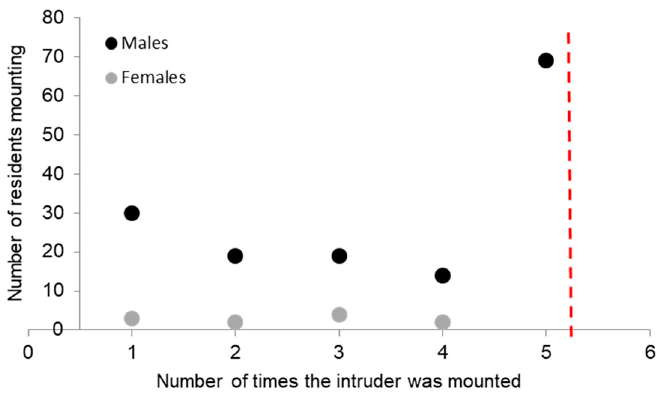
Figure 4. Frequency of mounting behaviour during tests by resident males (black) and females (grey). The test was immediately terminated after the fifth mount (red dashed line).